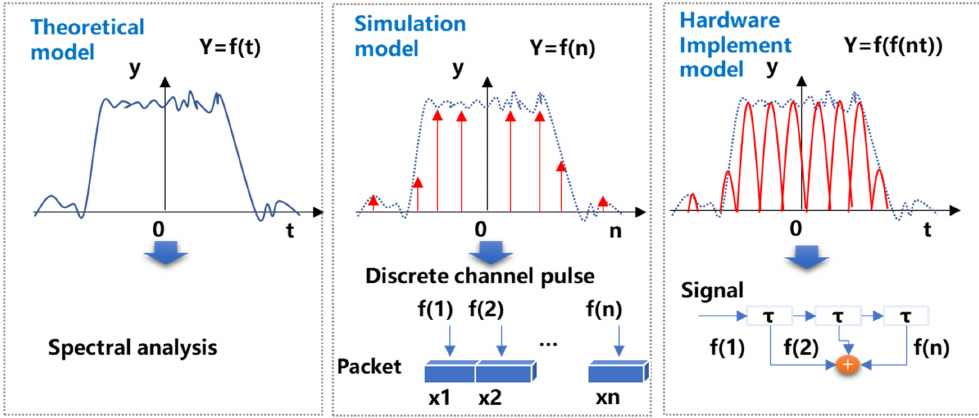
Figure 1. Theoretical analysis, simulation model, and hardware implementation model for the channel.